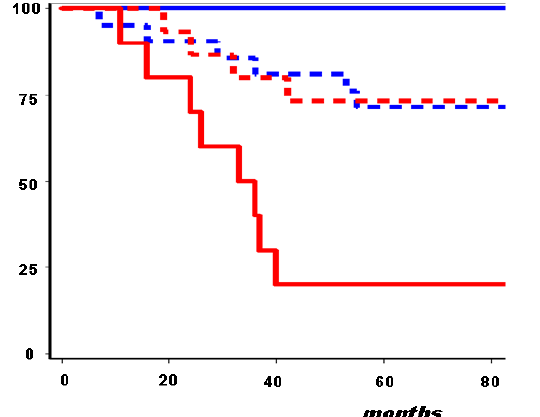
Figure 1. Probability of relapse-free survival (%) according to Gata3, PTCH1 and ALDH1 expression in 110 node-positive, ER-positive resectable breast cancers from postmenopausal patients treated with adjuvant tamoxifen. Blue solid line, patients with tumors presenting with all favorable markers (18 cases, 0 unfavorable events); broken lines, patients with tumors presenting with 1–2 unfavorable markers (72 cases, 22 unfavorable events); red solid line, patients with tumors presenting with all unfavorable markers (20 cases, 16 unfavorable